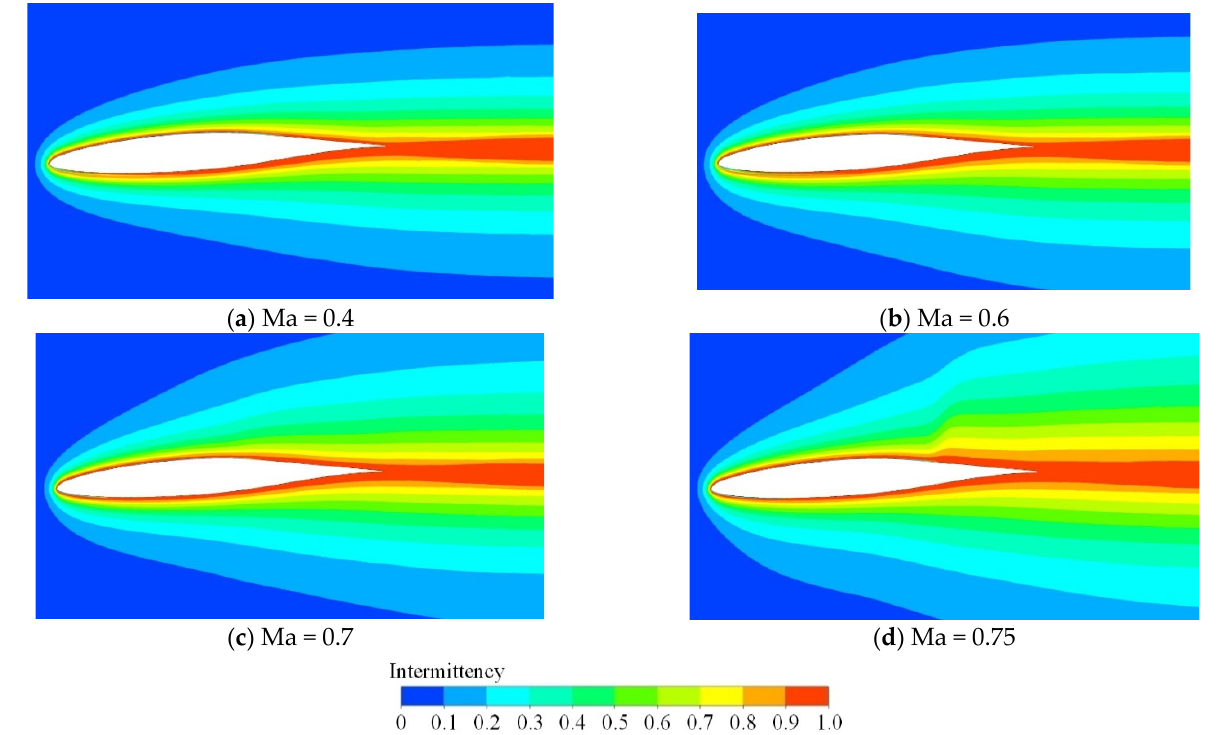
Figure 18. Influence of Mach number on distribution of intermittency ( ε = 0.5% , T w = 293 K , α = − 3°).